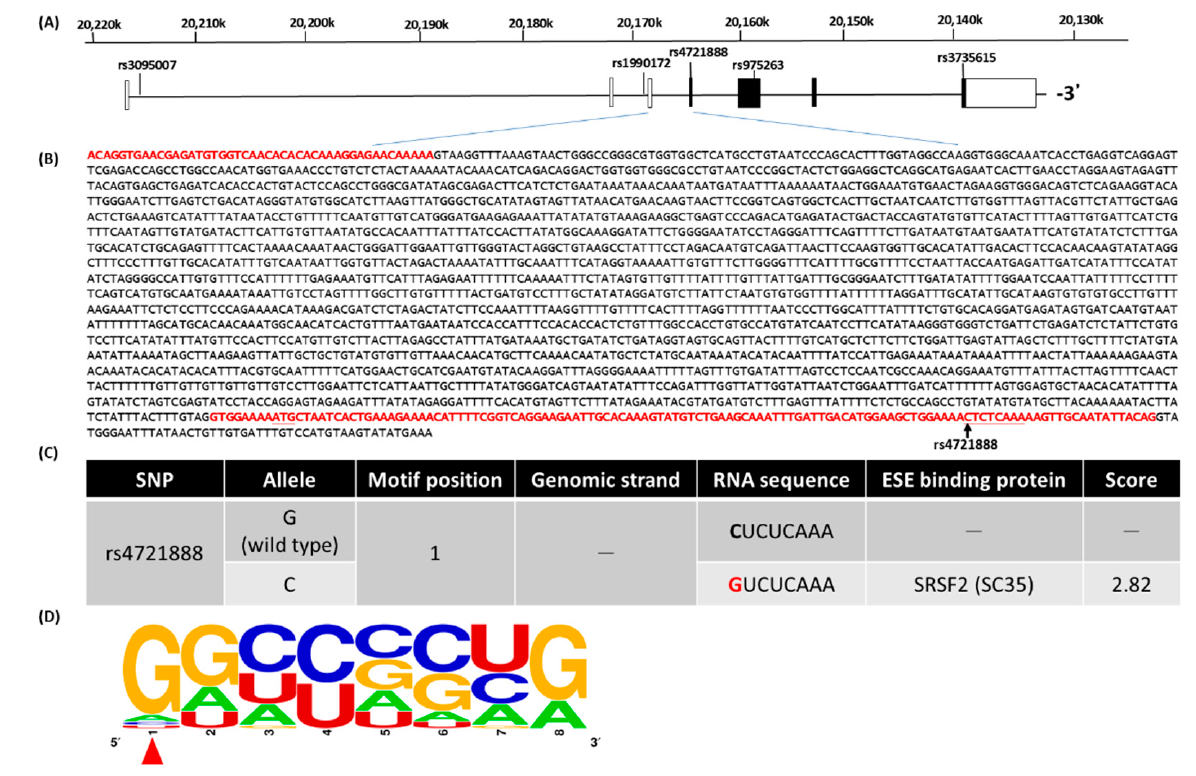
Figure 1. Exonic splicing enhancer binding site polymorphism from SNP rs4721888 [G/C] in the fourth exon of human MACC1 mRNA to increase oral cancer susceptibility among the Taiwan OSCC population. ( A ) The seven exons and six introns in the structure of the MACC1 gene, in addition to the longest open reading frame (ORF), are shown by the filled boxes for the chromosome positions (Chr.7, reference genome GRCh38.p7). There are five selected SNPs including rs3095007, rs1990172, rs4721888, rs975263, and rs3735615 in this study. ( B ) The detailed third and fourth exon-intron sequence of the human MACC1 (NM_182762.3) gene, highlighting the exon sequences with a red font. The underline and arrow indicate the translational start site and SNP rs4721888, respectively. ( C ) Prediction of the putative exonic splicing enhancer (ESE) by using the ESEfinder 3.0. The matrices are based on frequency values by functional systematic evolution of human SR protein motifs of SRSF2 (SC35). The red character indicates the position of the SNP rs4721888 C allele. ( D ) The binding motif of SC35 was created by WEBLOGO. The red arrow indicates the SNP rs4721888 [G/C] alleles that may cause the coding strand sequence to become a putative SC35 ESE binding